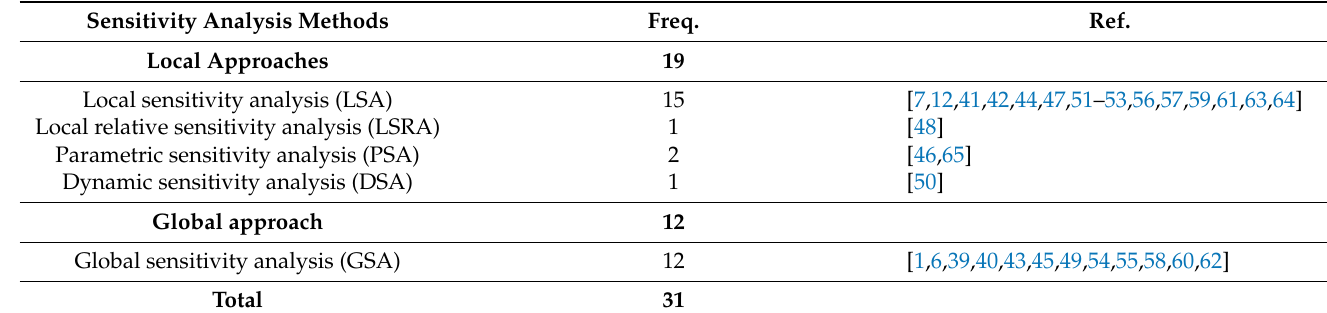
Table 2. Sensitivity analysis approaches and their frequency. Sensitivity Analysis Methods Freq.